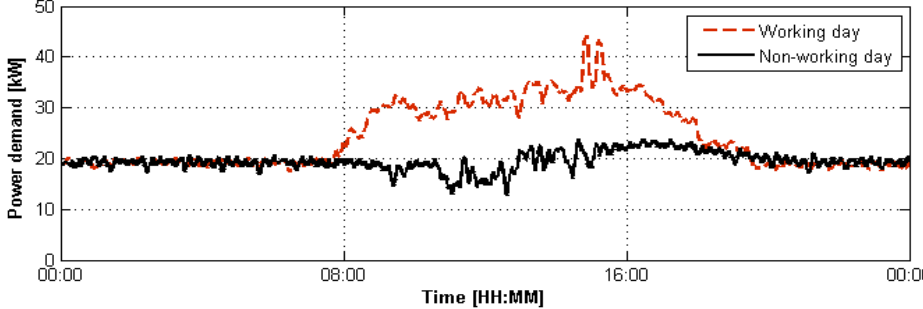
Figure 2. Energy demand profiles for working and non ‐ working days.